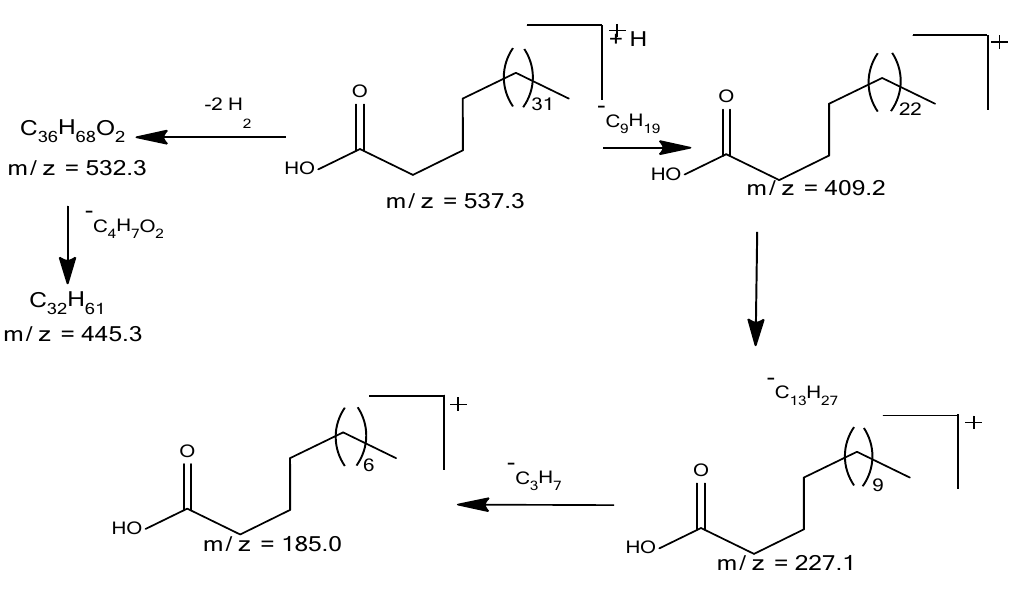
Figure 1: Structures of the compounds